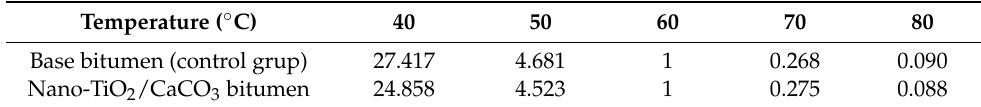
Table 6. The shift factor sat different temperatures.